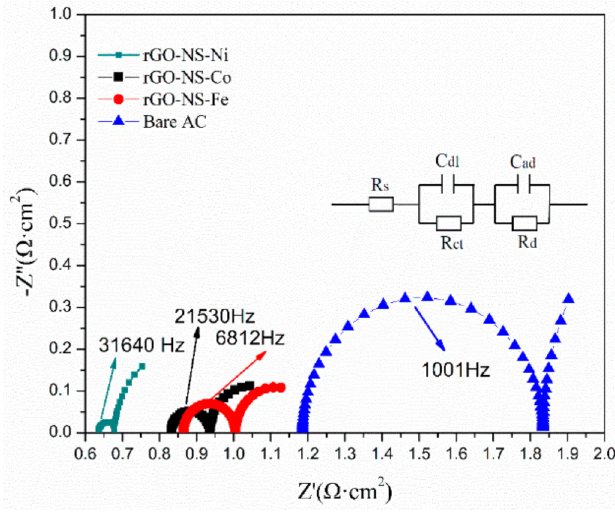
Figure 4. Electrochemical impedance spectroscopy (EIS) curve of rGO-NS-M anode. Table 1. Fitted resistance values of different rGO-NS-M